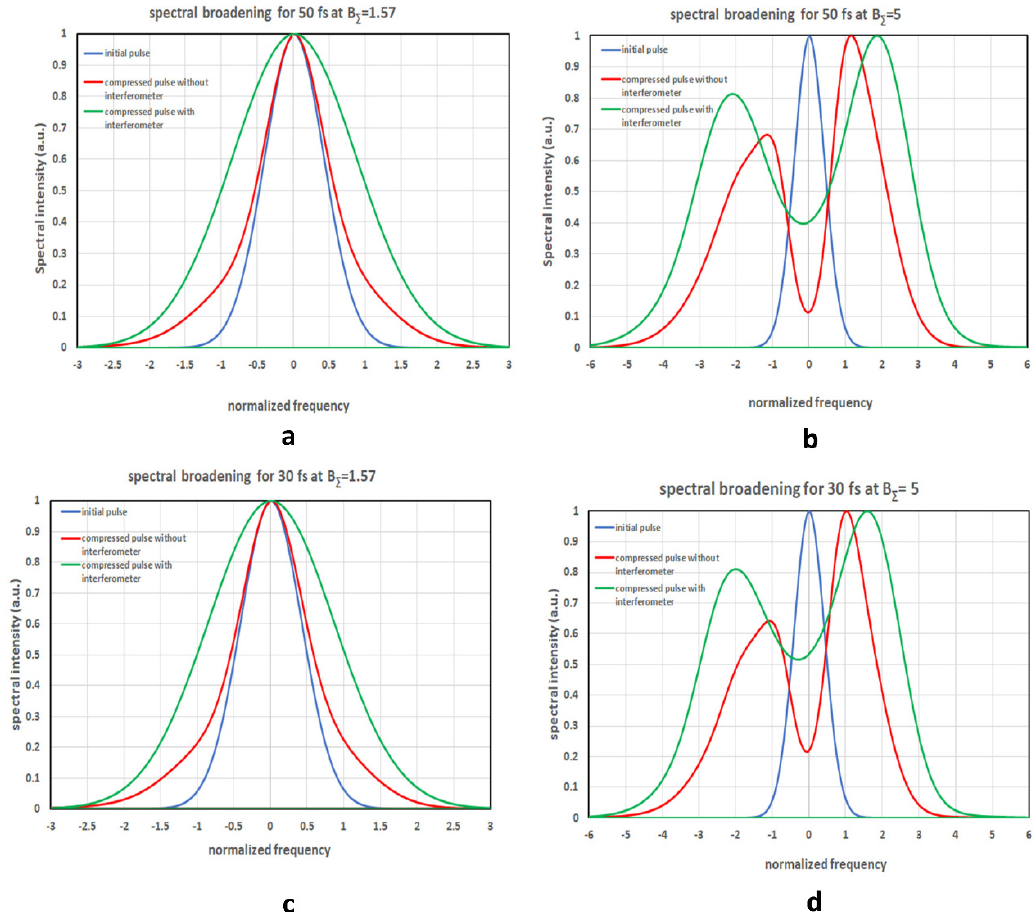
Figure 2. Spectrum of the initial pulse, compressed pulse in the scheme with interferometer (Figure 1a), and compressed pulse in the scheme without interferometer (Figure 1b) for 50 fs ( a , b ) and 30 fs ( c , d ) input pulses at B Σ = π /2 ( a , c ) and B Σ = 5 ( b , d ). Horizontal axes are normalized to the input pulse bandwidth.